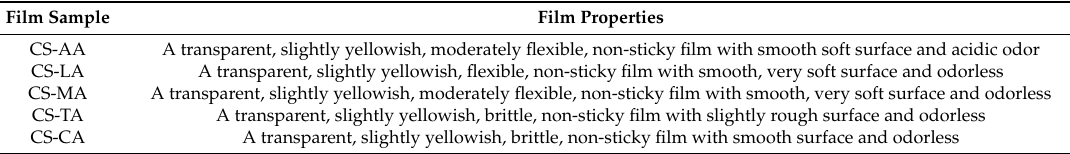
Figure 1. Images of the shrimp chitosan films manufactured with acetic, lactic, maleic, tartaric and citric acids as film casting solvent. A logotype was placed below the samples to better demonstrate the appearance of the films. Table 1. Characteristics of shrimp chitosan films formulated with different organic acids.